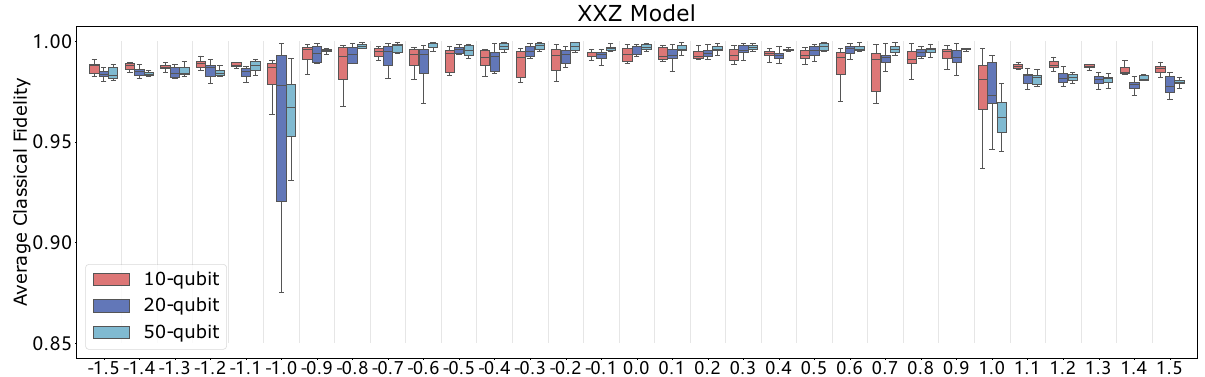
ten-, twenty- or fi fty-qubit ground states of XXZ model (2), respectively, with respect to different values of Δ ∈ { − 1.5, − 1.4, … ,1.5}. Given outcome probability distributions for all m 2 S , each box shows the average classical fi delities of pre- dicted outcome probabilities, averaged over all measurements in M n S , for 10